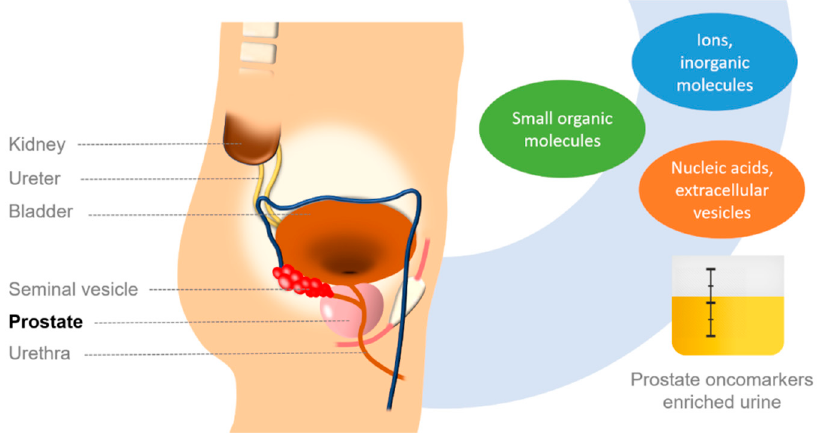
Figure 1. Human genito-urinary system with the prostate located right below the bladder, making urine an accessible source of many precious (not just) prostate oncomarkers compared to more complex biological matrices, such as serum, plasma, or cell lysate to be used in sensing applications. The human ZIP1 gene for the zinc transporter 1 precursor is usually down-regulated in malignant prostate cells [23], hence the diminished ability of PCa cell lines to enrich in Zn 2+ . Other examples of membranous proteins with an aberrant expression in PCa cells include a prostate specific membrane antigen (PSMA, a transmembrane glycoprotein ex- hibiting a hydrolytic activity with a prognostic value also) [25,26] or the nuclear receptor superfamily of androgen receptors, playing an important role in castration-resistant pros- tate cancer [27]. Compared to non-malignant cell lines, in the RWPE-1 cell line (non-neo- plastic adult human prostatic epithelial cells) a lower level of zinc content was detected [28]. This can be effectively used for in situ fluorescent zinc-sensing for early PCa diag- nostics. A good example is a dansyl-Gly-Pro-Trp-Gly-NH 2 -based fluorescent sensor, where a fluorophore (a dansyl group) is an electron acceptor, Gly-Pro is the linker, Trp is the bind- ing group, and the rest of the molecule is hydrophilic. In a Zn-rich environment, usually quenched fluorescence is “turned on” due to interrupted electron transfer, with Zn con- centration as low as 49.7 nM [29]. Endogenous Zn-sensing was also used by Fu et al . , where the authors prepared a novel diketopyrrolopyrrole (DPP)-based fluorescent zinc ion probe designated as DPP-C2. The fluorescent intensity was directly proportional with the environmental zinc concentration and distinguished malignant DU145 and PC3 cells from normal prostate epithelial cells (RWPE-1) [28]. Photoactivation (UV light-induced removal of protecting groups) of Zn-binding sensor molecules and their application in vivo has also been reported [30]. An electrochemical method for selective mobile Zn 2+ ions detection in real sera based on screen-printed electrodes (SPE) has been introduced re- cently [31]. SPEs modified with zincon and an electrochemically exfoliated graphite com- posite were able to detect Zn 2+ down to 5 μ g mL − 1 using differential pulse voltammetry (DPV) with pre-concentration and electrodeposition steps. Although this sensor was cheap, reproducible (RSD ≤ 7%), and stable for several weeks, the measurement of Zn 2+ currently remains useful only as an analysis complementary to that of other PCa markers, being especially useful for measuring intracellular zinc content (i.e . , after initial prostate biopsy).